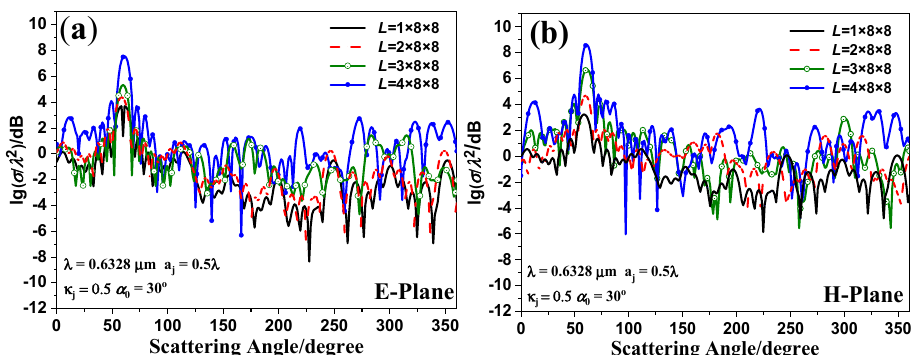
Figure 12. Illustration of a structure of 512 assembled chiral particles composed in an 8 × 8 × 8 square array.